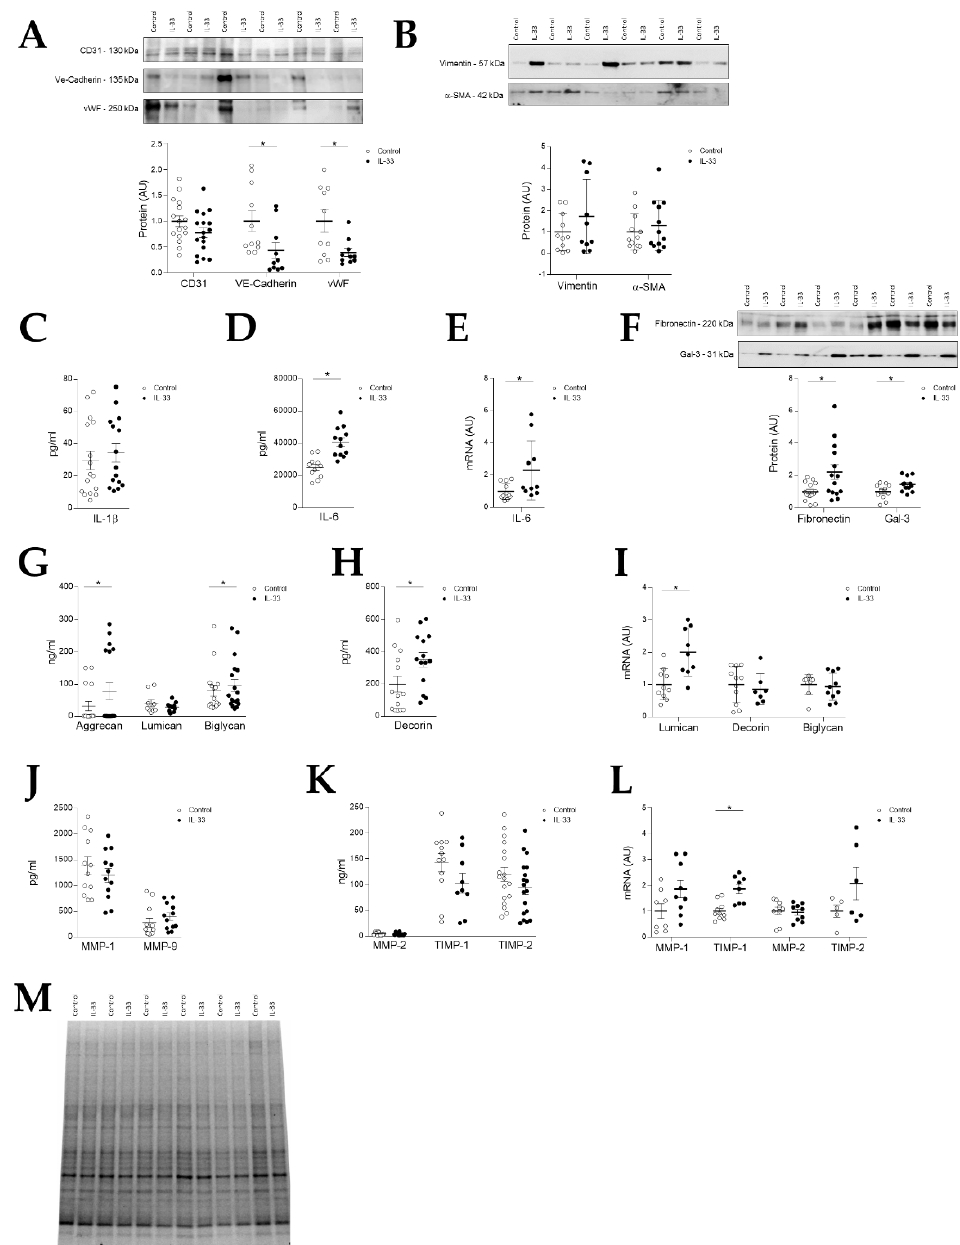
Figure 4. Effects of IL-33 on human mitral VECs. ( A ) Quantification of VECs markers (CD31, VE-cadherin and Von Willebrand factor) in VECs treated with IL-33 at protein levels. ( B ) Quantification of VICs activation markers (vimentin and α -SMA) in VECs treated with IL-33 at protein levels. ( C , D ) Quantification of secreted inflammatory markers IL-1 β and IL-6 in VECs treated with IL-33. ( E ) Quantification of mRNA of IL-6 in VICs treated with IL-33; ( F ) Quantification of fibronectin and Galectin-3 at protein levels in VICs treated with IL-33; ( G ) Quantification of extracellular proteoglycans aggrecan, lumican and biglycan in VECs treated with IL-33; ( H ) Quantification of secreted decorin in VECs treated with IL-33; ( I ) Quantification of mRNA of lumican, decorin and biglycan in VECs treated with IL-33; ( J ) Quantification of secreted MMP-1 and MMP-9, ( K ) TIMP-1, MMP-2, TIMP-2 at protein levels in VECs treated with IL-33; ( L ) Quantification of mRNA of MMP-1, TIMP-1, MMP-2 and TIMP-2 in VECs treated with IL-33; ( M ) Representative Stain free. Box plots show the individual datapoints and the horizontal bars indicate the mean and SEM in arbitrary units versus the control group. For Western blot experiments, protein densitometry was expressed in arbitrary units (AU) once normalized to stain-free and b-actin. Representative blots have been displayed when appropriate. * p < 0.05 vs. control. IL: Interleukin; vWF: Von Willebrand factor; Gal-3: Galectin-3; MMP: Matrix metalloproteinase; TIMP: Tissue inhibitor of